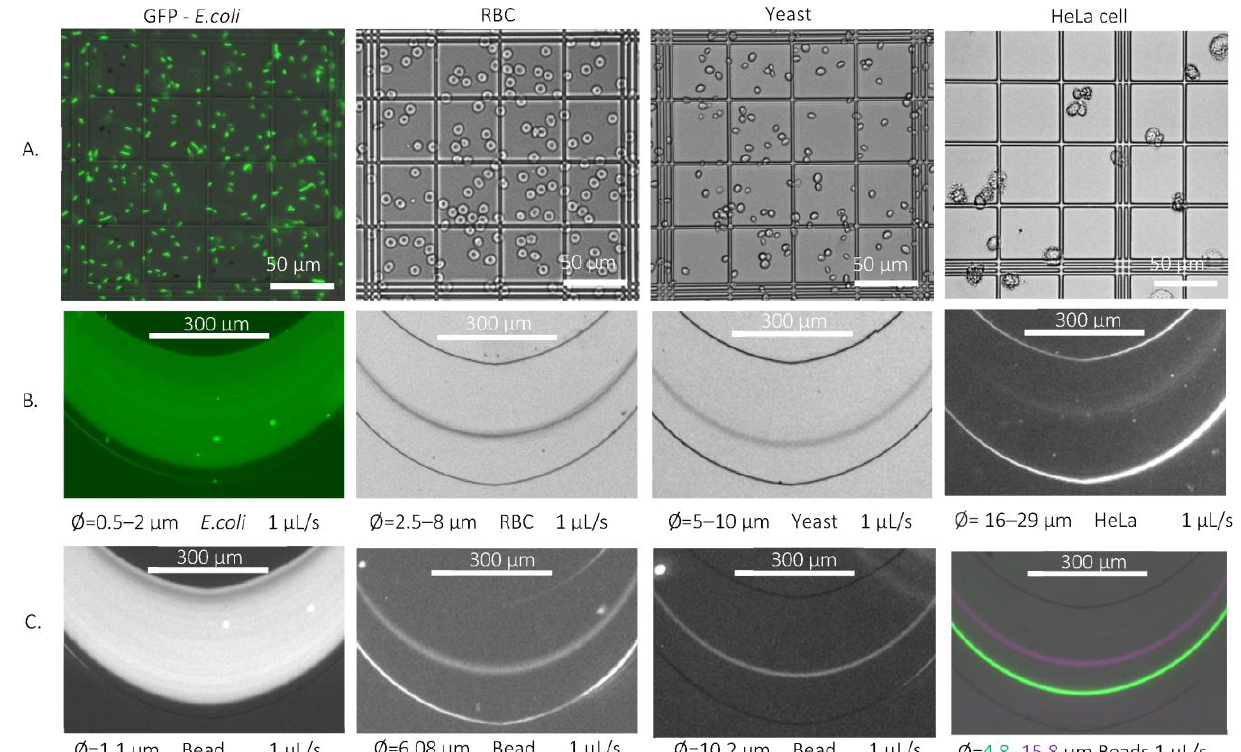
Figure 4. The size limit of lateral focusing in channel H25_W cr 50 at 1µL/s. The applied bead sizes are Ø = 0.5, 1.1, 1.97 and 2.9 µm.